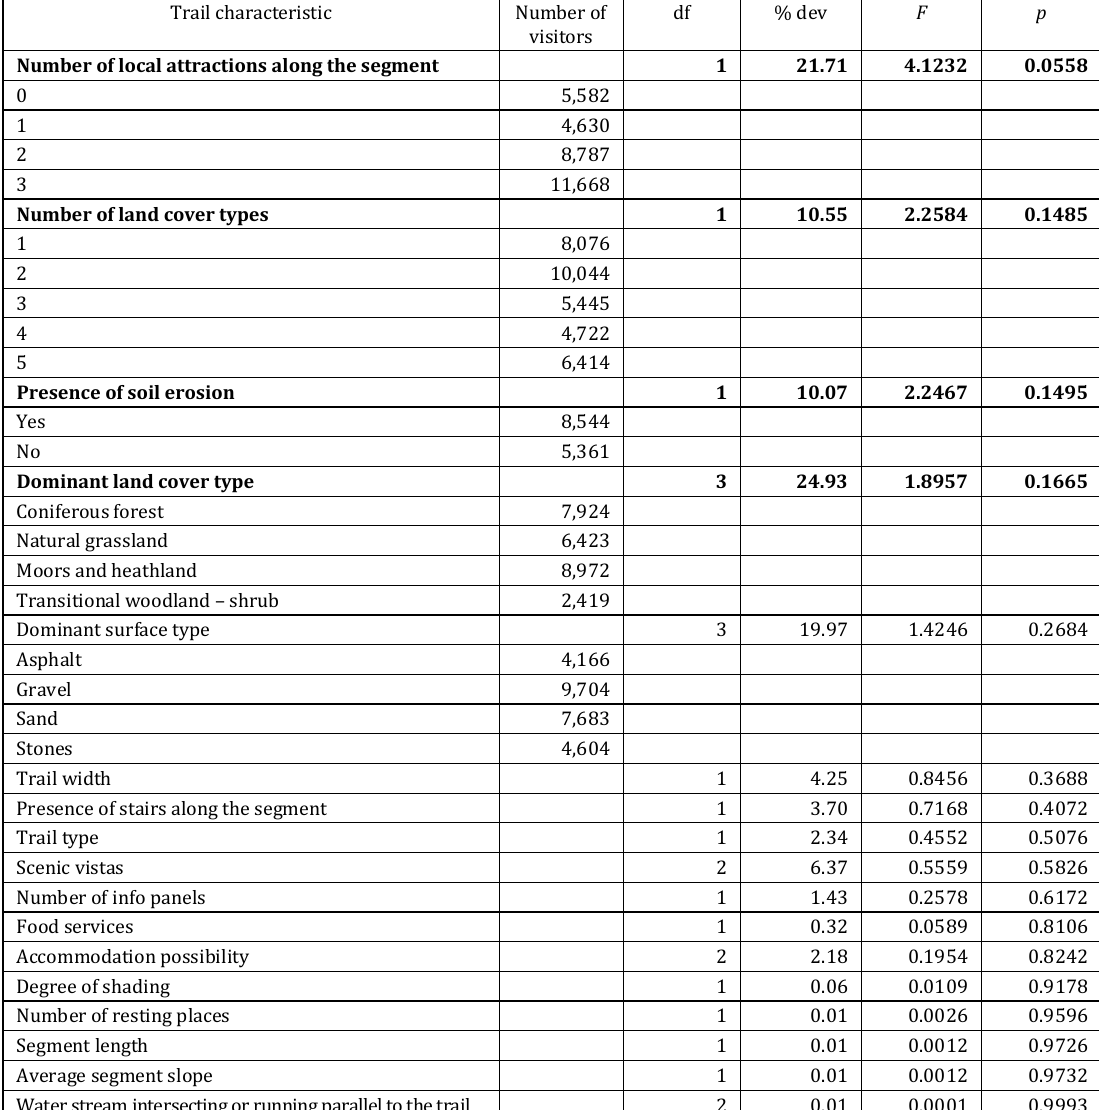
Table 4. Results of statistical analyses. Trail characteristics explaining more than 10% of variability in trail visitation data are in bold. Only the number of local attractions along the segment could be considered as marginally significant. df = degrees of freedom, % dev = proportion of explained variability within partial tests, F = F-statistic, p = obtained probability Trail characteristic Number of df % dev F p visitors Number of local attractions along the